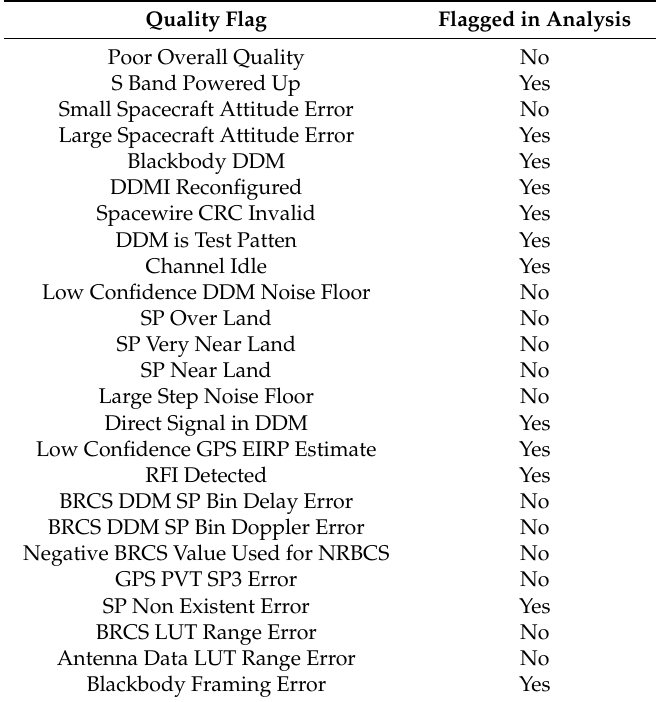
Table A2. CYGNSS L1 data quality flags used in this